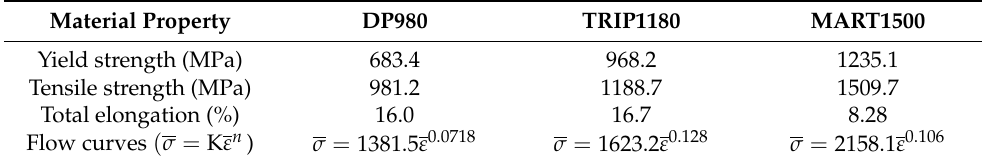
Figure 1. Engineering stress–strain curve of DP980, TRIP1180, and MART1500. Table 1. Material properties of DP980, TRIP1180, and MART1500. Table 1. Material properties of DP980, TRIP1180, and MART1500.